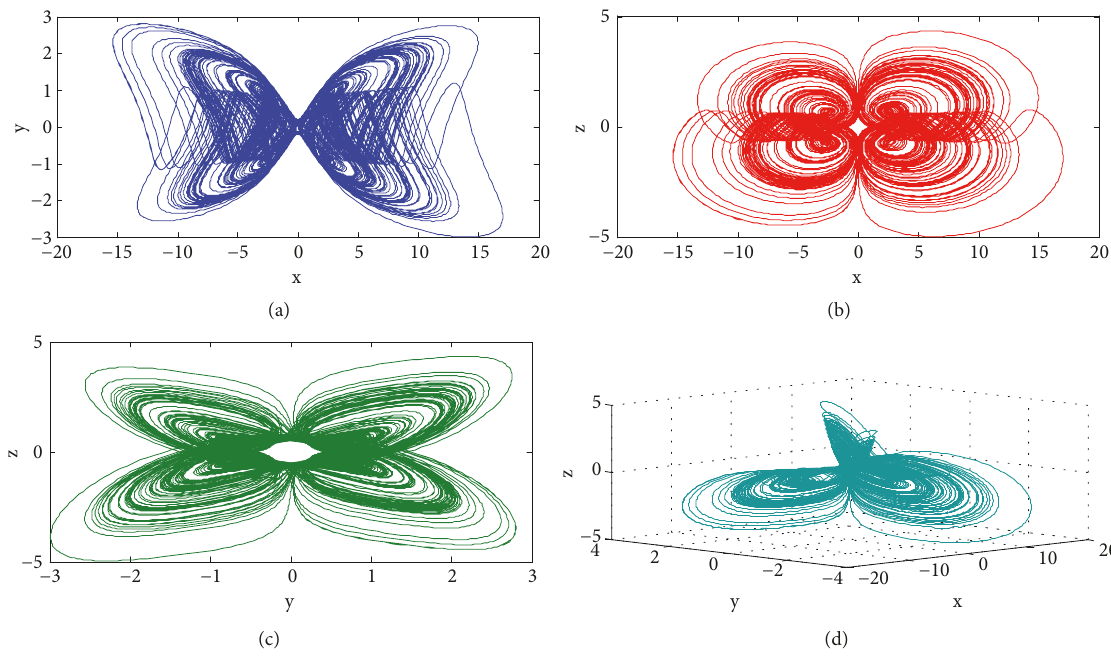
Figure 1: Four-scroll attractor for Zhang system: (a) 𝑥 − 𝑦 phase plane, (b) 𝑥 − 𝑧 phase plane, (c) 𝑦 − 𝑧 phase plane, and (d) phase